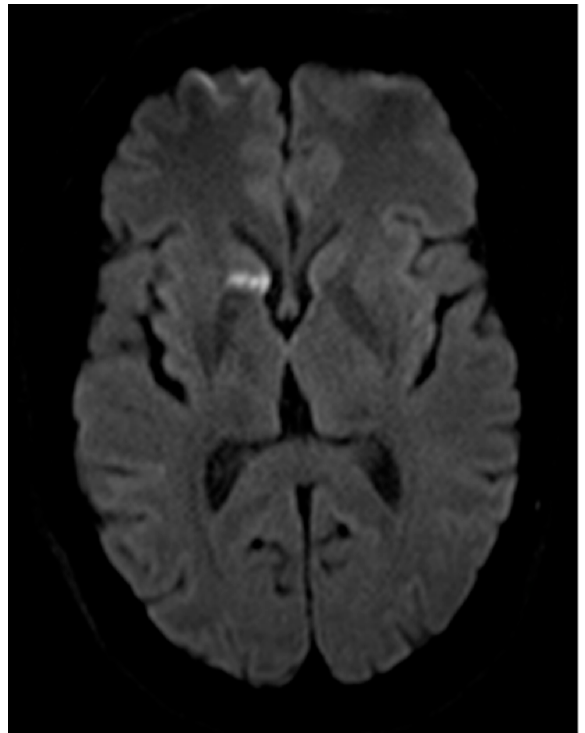
Figure 1. Cerebral DWI (b = 800) demonstrating subacute cerebral ischemia, in this case prior to embolization of multiple PAVMs. The newly developed lesion arose between screening for PAVM and the day of interventional therapy, but the patient did not exhibit any clinical signs or symptoms. This example highlights the importance of DWI for the detection of pre-existing cerebral ischemia, as well as peri-interventional cerebral insult.